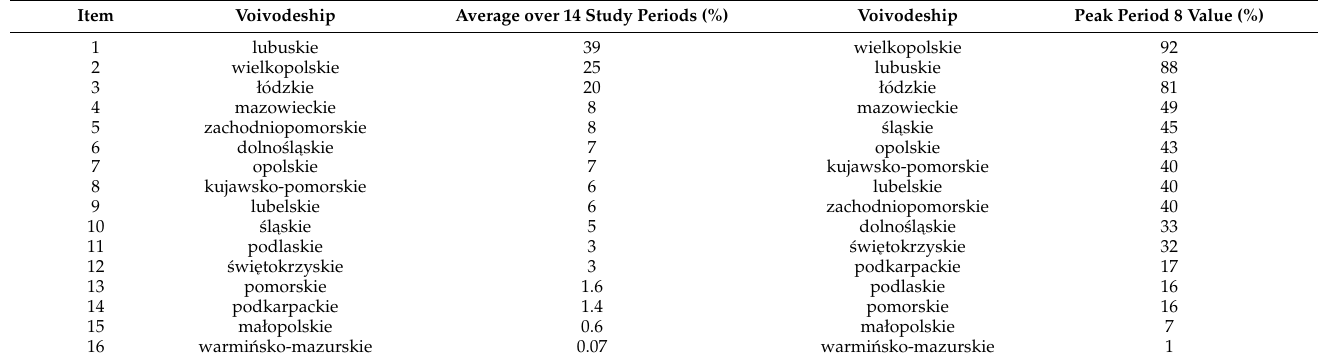
Table 2. Ranking of provinces in terms of area at risk of drought (%) at the area of the voivodeship at draught